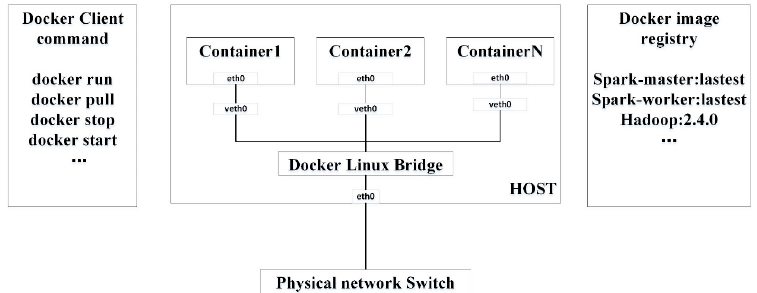
Figure 3. Docker framework for lifecycle management of containers in a host. Docker images are stored in Docker image registries. Each host has a Docker engine that deploys and controls these containers as requested by Docker clients.